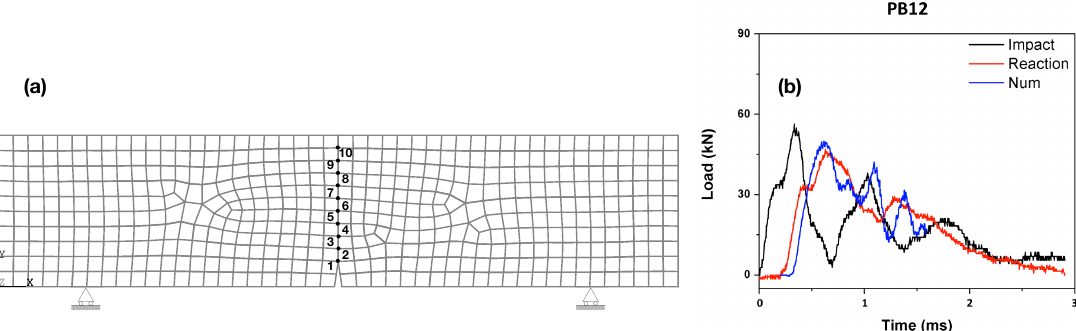
Figure 15. ( a ) Distribution of mesh in the specimen and ligament nodes; ( b ) evolution of the numerical and experimental reaction forces contrasted with the impact forces at loading rate of 1.77 m/s